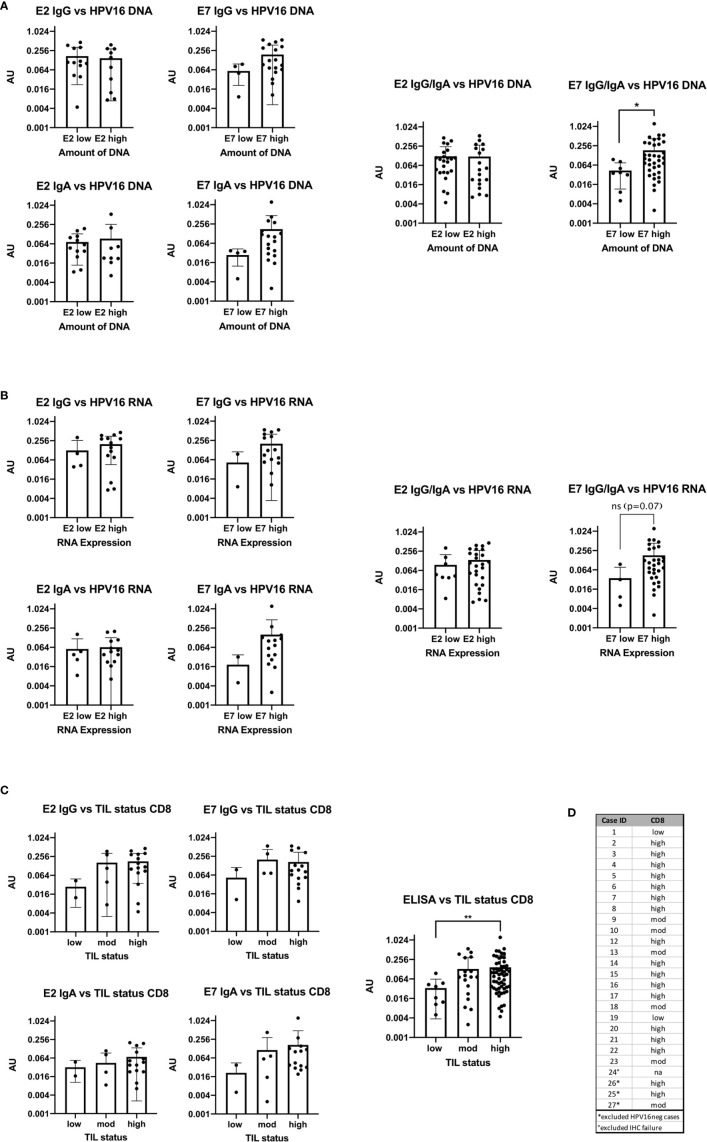
Bar plots showing the comparison of antibody levels with E2 and E7 expression levels on DNA, RNA and with the TIL status (A) High DNA expression level of E7 is accompanied with statistically significant higher AU values (p=0.0245) of E7 IgG in the serum (B) the RNA expression level and ELISA antibody units are congruent to the DNA results, but not statistically significant (p=0.07). (C) Patients with high or moderate TIL status assessed by CD8 have higher AU values in the serum for E2 and E7 IgG than patients with TILlow tumors. The same trend is seen for E2 and E7 IgA. Combining all ELISA data to a summarized seropositivity the TILhigh HNSCC show significantly higher AU values than the low. (**: p≤0.01). (D) Table showing the case numbers and their TIL status for CD103 and CD8.